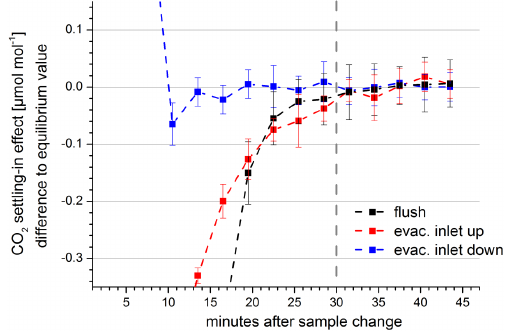
Fig. A1. Comparison of the different sample change-over meth- Figure A1. Comparison of the different sample change-over methods for CO 2 . The settling-in 2 ods for CO 2 . The settling-in effects are shown as relative deriva- effects are shown as relative derivation from the equilibrium value defined by the average of 3 tion from the equilibrium value defined by the average of the last the last five measurements. Sample exchange by flushing only is shown in black, sample 4 five measurements. Sample exchange by flushing only is shown in exchange via evacuation, as used in the standard operation conditions, in blue with standard 5 black. Sample exchange via evacuation, as used in the standard op- cell orientation and in red with the cell turned upside down. Measurements are shown centred 6 eration conditions, is in blue with standard cell orientation and in in their 3 min interval. 7 red with the cell turned upside down. Measurements are shown cen- tred in their 3min